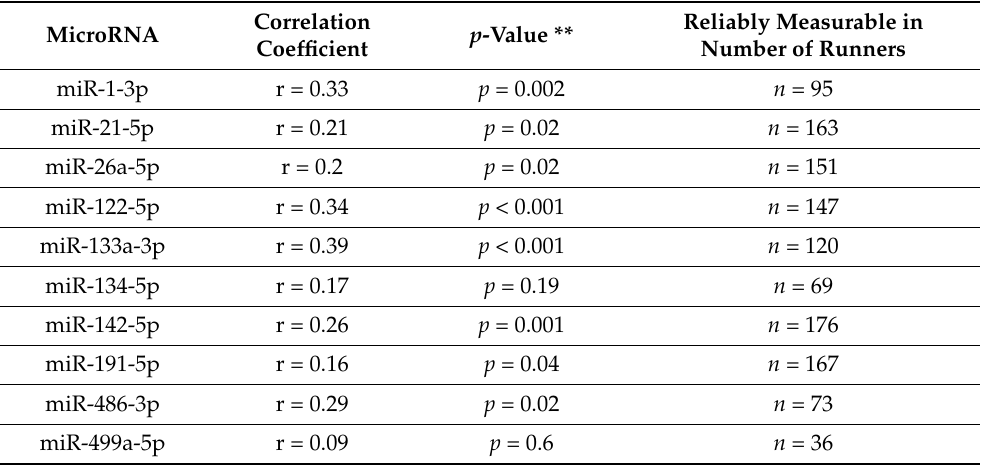
Table 3. Pearson’s correlation coefficient for correlations between Log (relative quantity of microRNA after the marathon) * from qPCR and Log (cTnT after the marathon) *. Reliably Measurable in Correlation p -Value ** MicroRNA Number of Coefficient